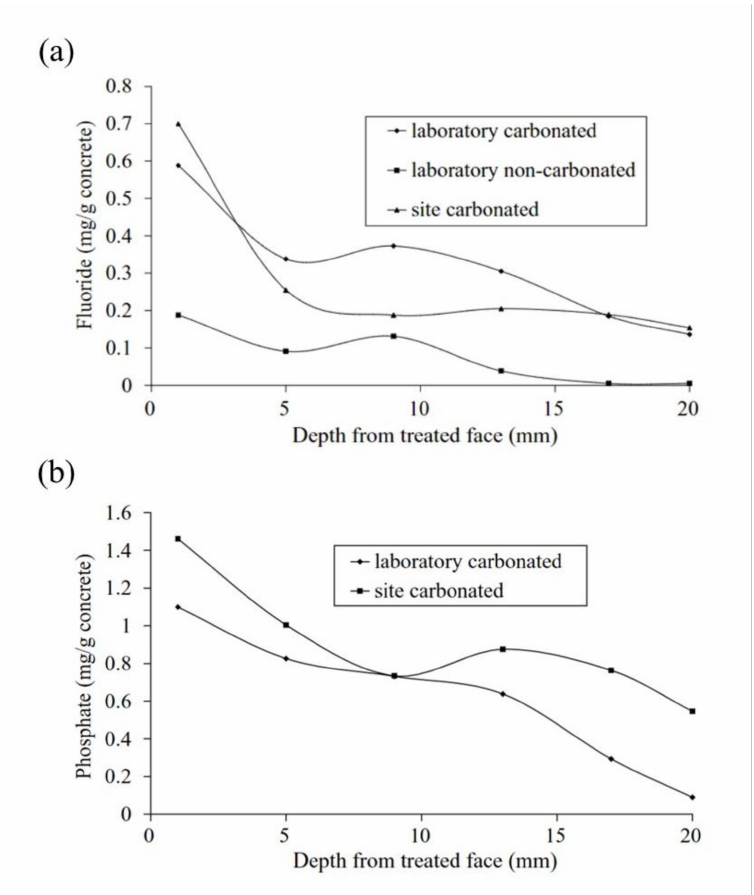
Figure 1. Penetration depth of inhibitors acting as migrating corrosion inhibitors (MCI): ( a ) water- soluble fluoride and ( b ) water-soluble phosphate [15]. Reproduced with permission from Ngala, V. et al., Corros. Sci.; published by Elsevier,